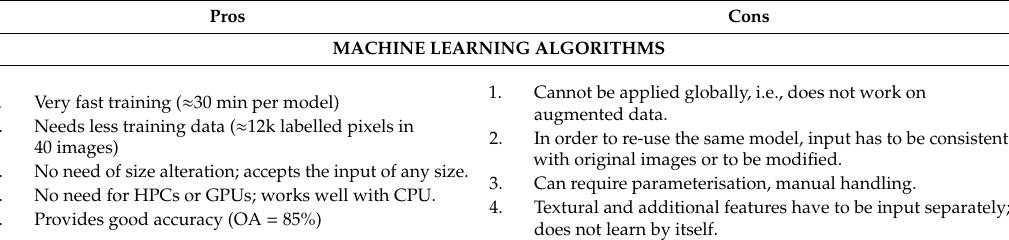
Table 5. Pros and cons of ML vs. DL for mapping ecotopes, Clara